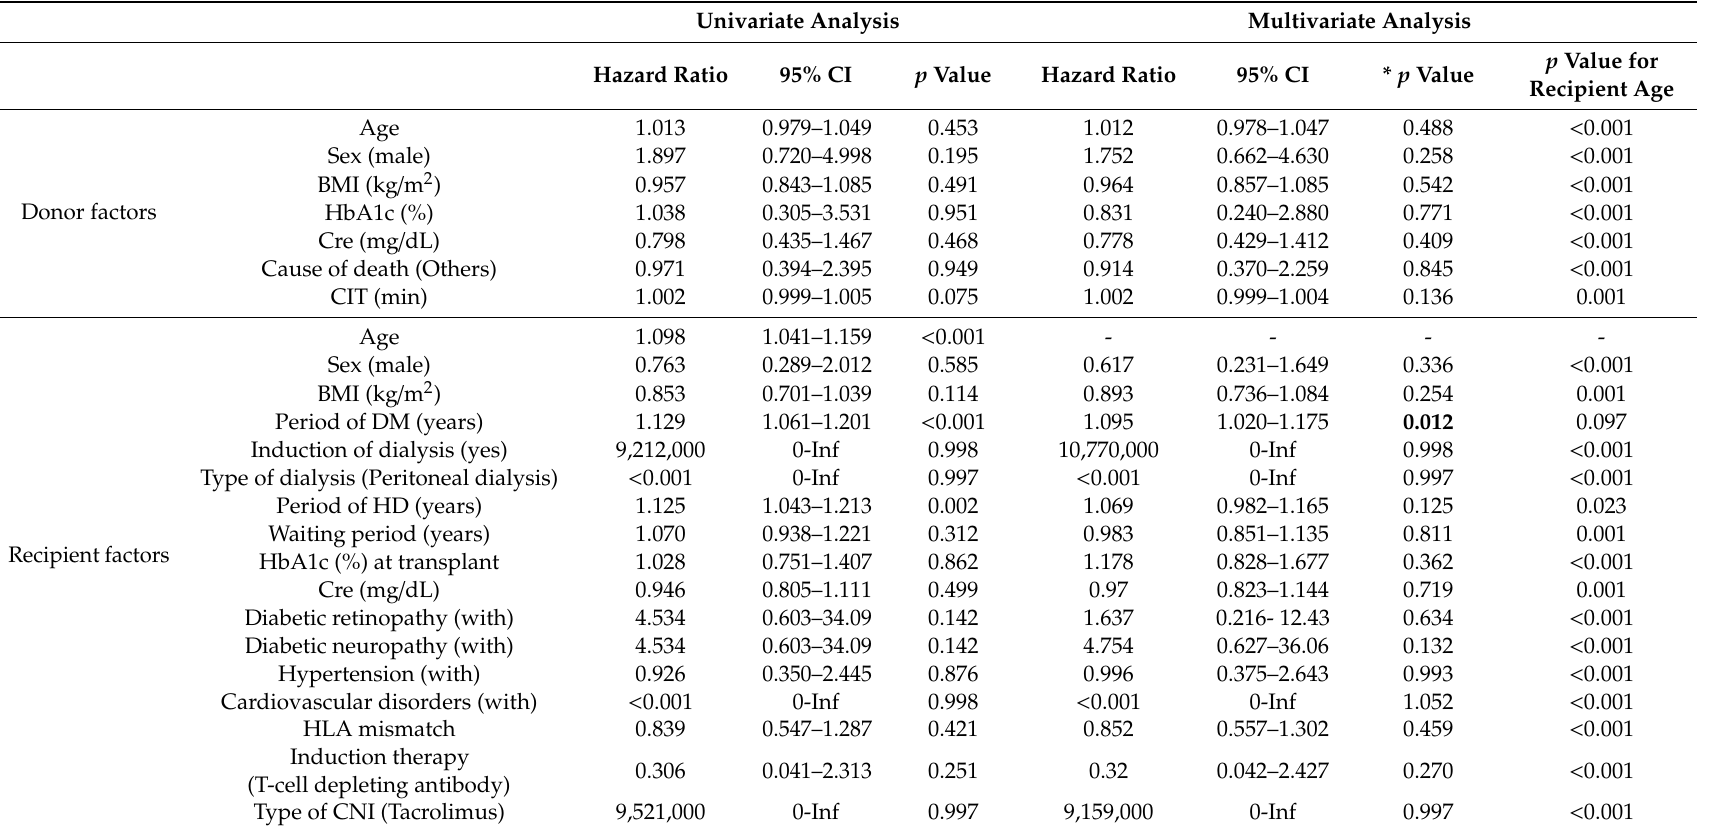
Table 3. Factors a ff ecting the patient survival after SPK 2000–2018. SPK n =